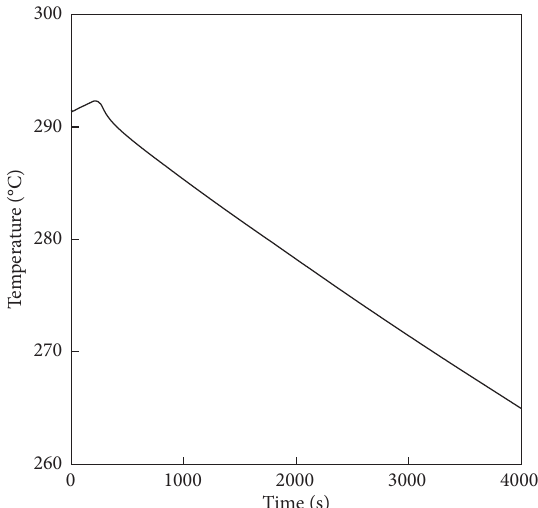
Figure 7: The average temperature of the primary circuit. Figure